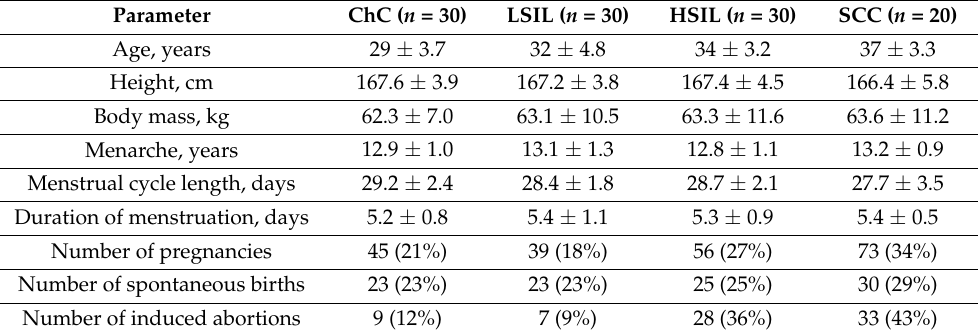
Table 1. Demographic and clinical data of the patients. There were no significant differences between the groups ( p -value >